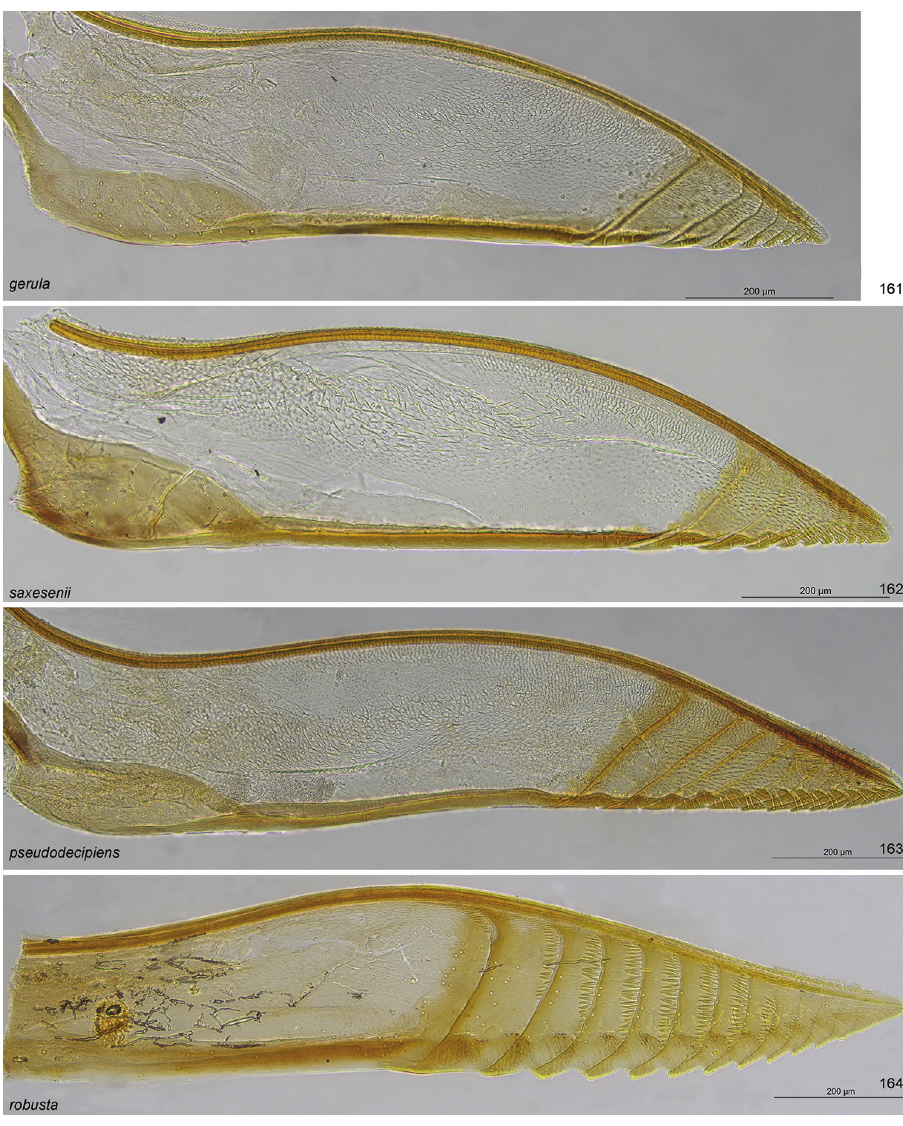
Figures 161–164. Lancets of Pristiphora . 161 gerula DEI-GISHym20980 162 saxesenii DEI- GISHym20840 163 pseudodecipiens DEI-GISHym31583 164 robusta